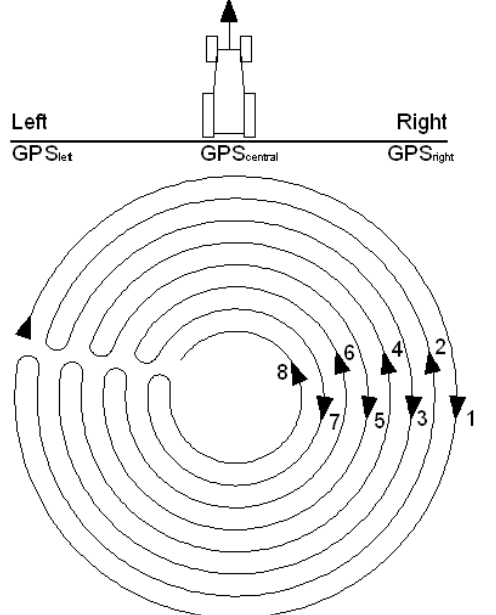
Figure 2. Field test performed in a plot with a boom sprayer that followed eight circular trajectories. The boom was equipped with three GPS systems with RTK correction and with a tractor with the commercial self guidance system John Deere Autotrac Universal, which was configured to make concentric pathways each separated by 16.75